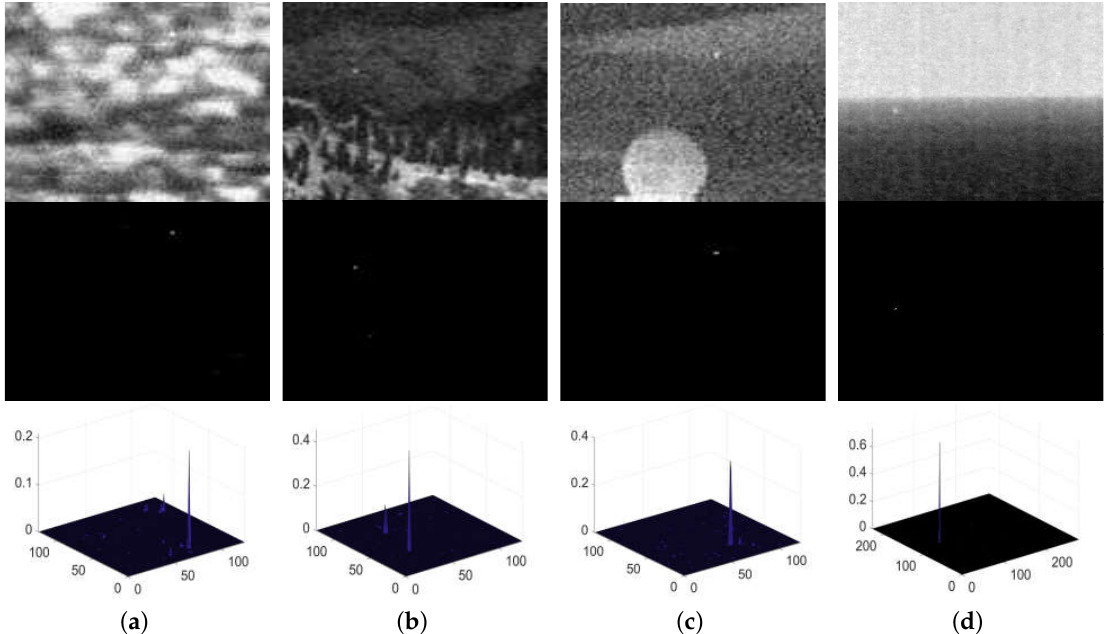
Figure 6. Noise-added images and their confidence maps obtained by applying the proposed algorithm: ( a – d ) correspond to the raw images of the first row in Figure 2, respectively. The first row is the noise-added images, and the variances of the added noise were: ( a – d ) 0.005, 0.01, 0.005, and 0.0002, respectively. The second row displays the confidence maps of the noise-added images, and the three-dimensional meshes of the confidence maps are placed in the third